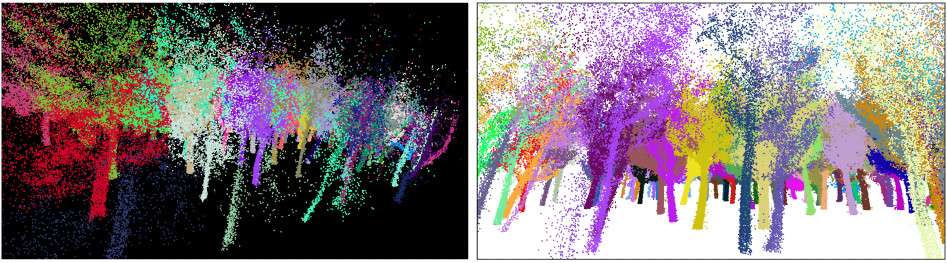
Figure 15. Zoom screenshots at the segmented point